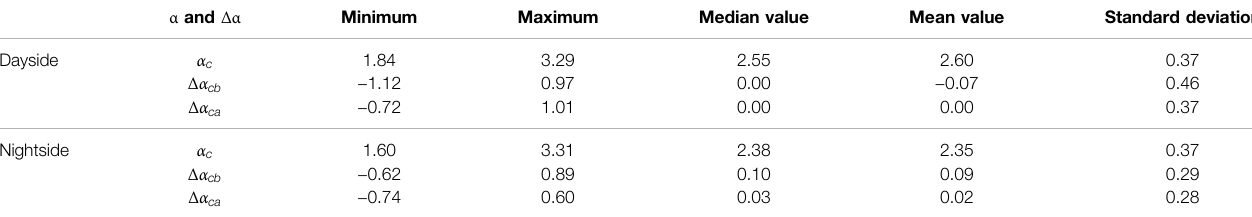
TABLE 1 | Minimum, maximum, median, and mean values and the standard deviation of α and Δα at the dayside and the nightside. α and